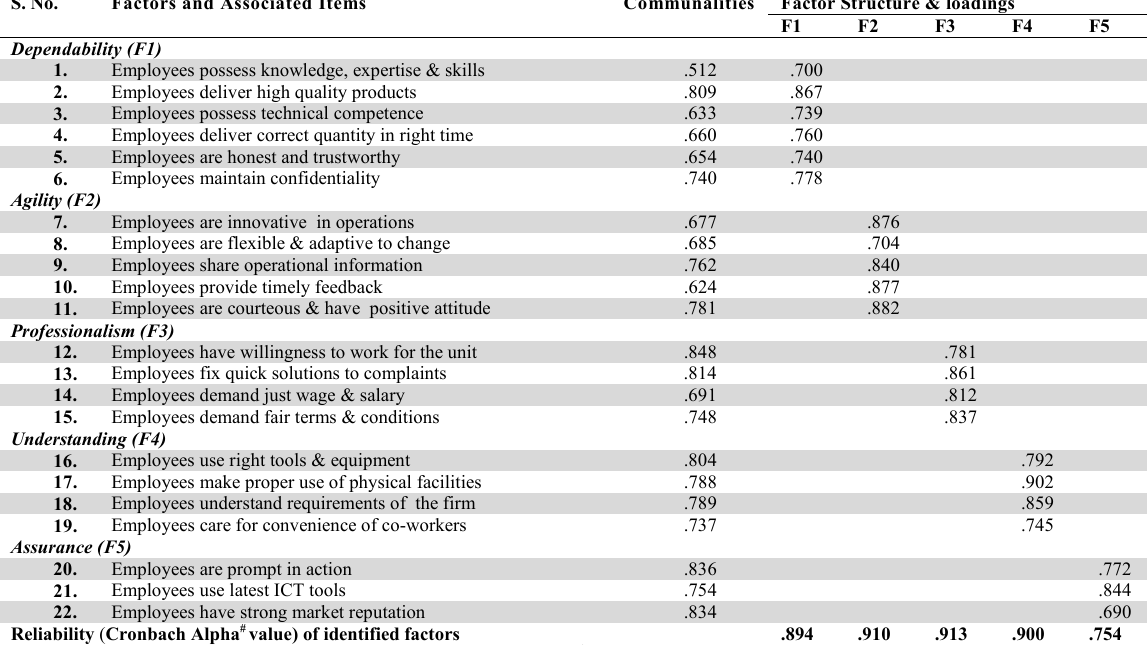
Communalities, Factor Structure and Loadings for Items of Scale for measuring ESQ Principal Components Method with Varimax Rotation Loading ≥